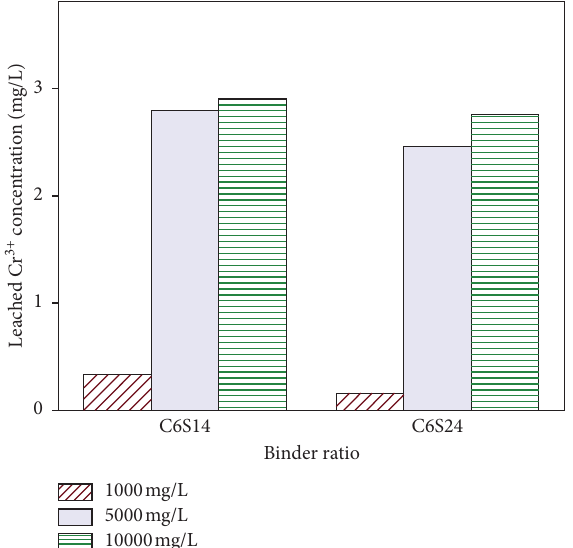
Figure 7: Relationship between the leached Cr 3+ concentration and soda residue content of the stabilized Cr-contaminated soils.